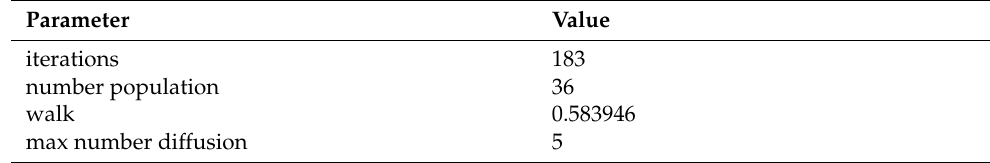
Table 2. Results of SMAC